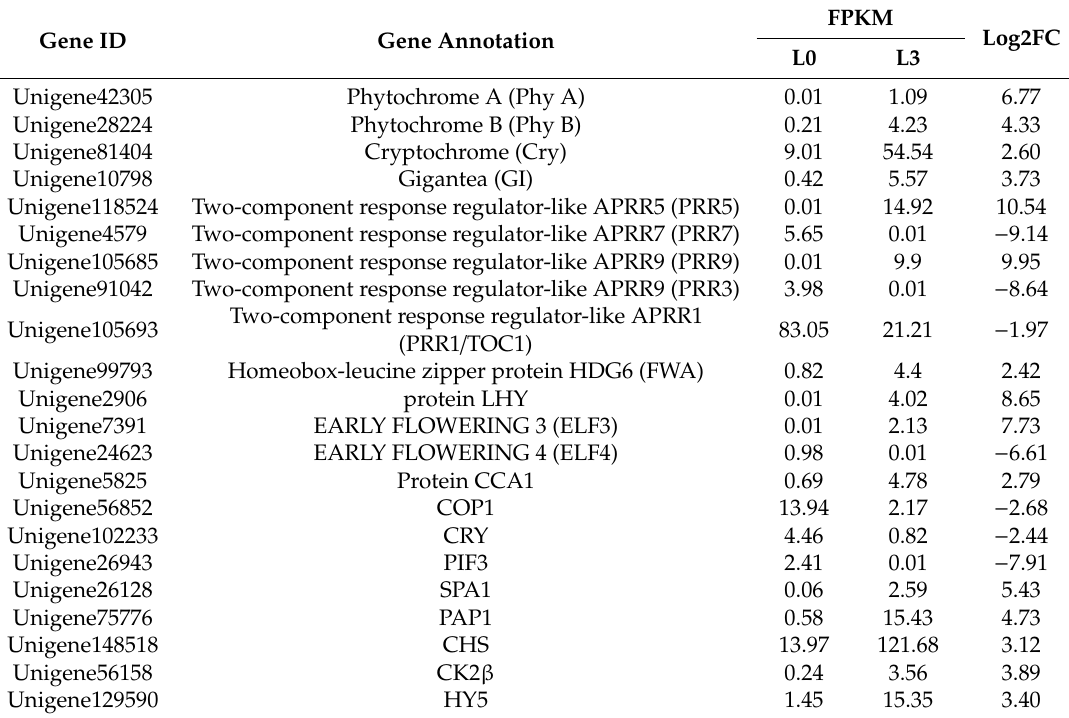
Table 3. The main di ff erential genes of circadian rhythms that regulate flowering during photoperiod between L0 and